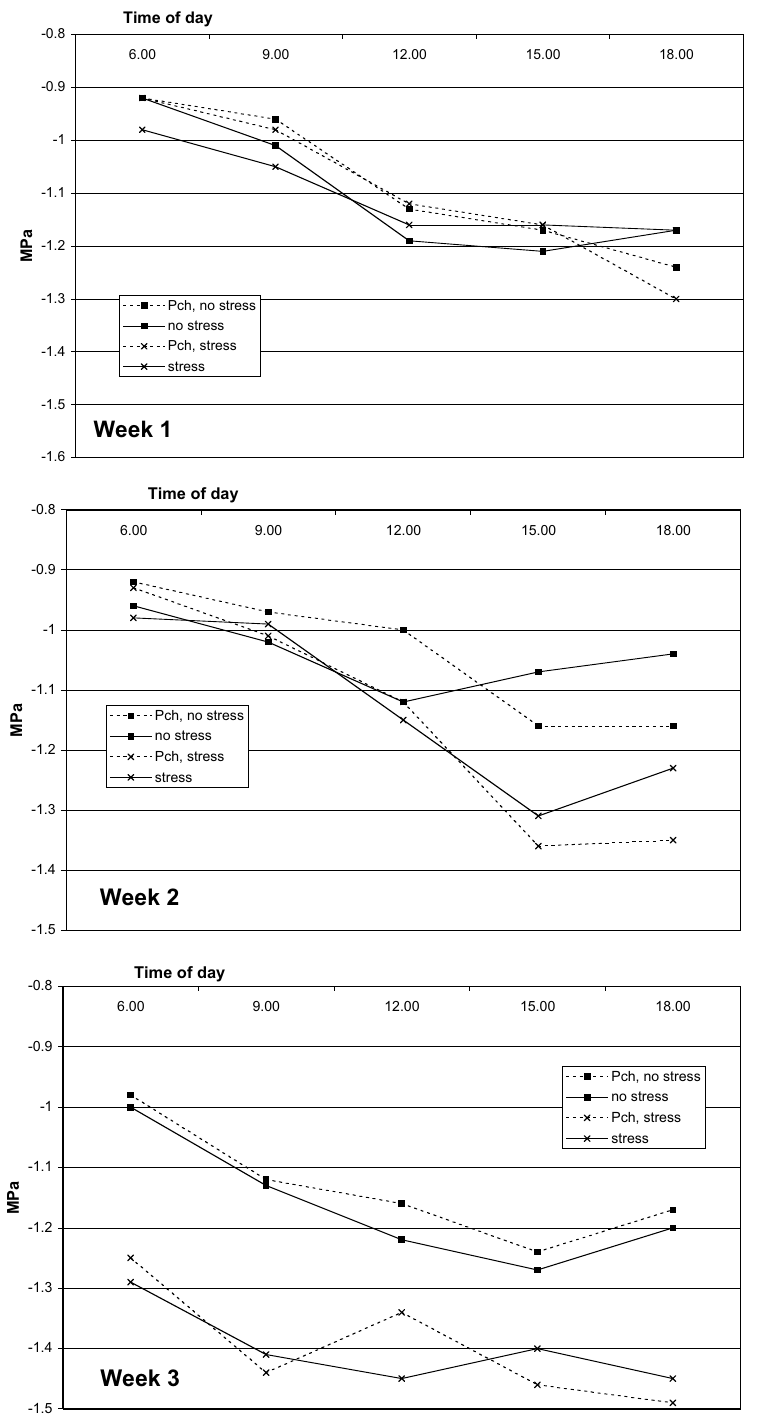
Fig. 3. Effects of water stress on diurnal measurements of leaf water potential of infected and uninfected Zinfandel grapevines (Year 1, 2004, weeks 1, 2,